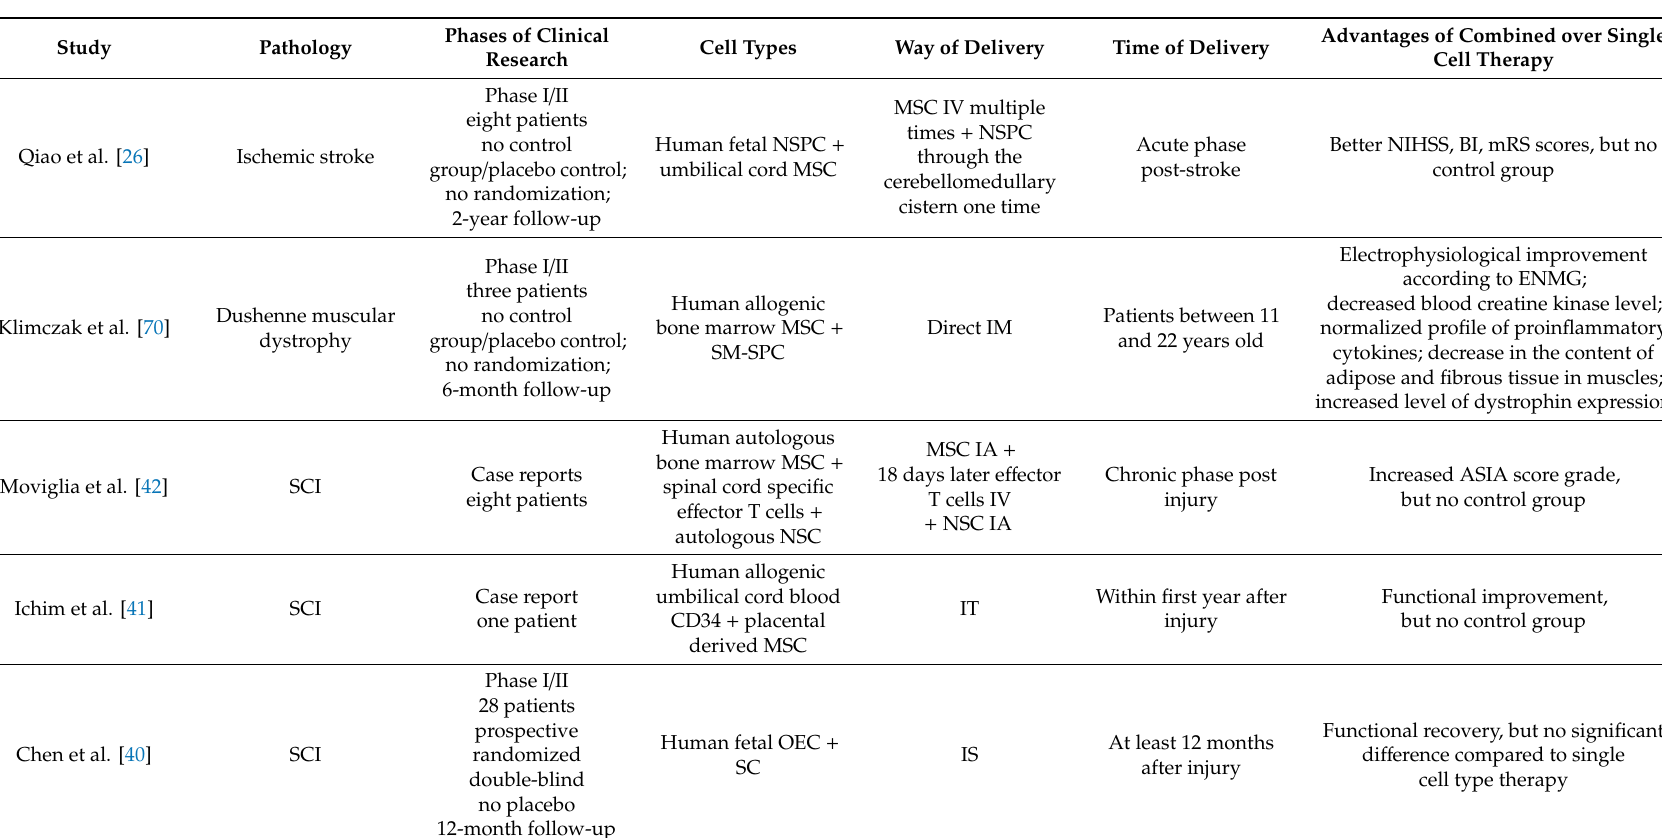
Table 2. Summary of the results of combined cell therapy and clinical trials. ENMG—electroneuromyography; IA—intraarterial; IV—intravenous;